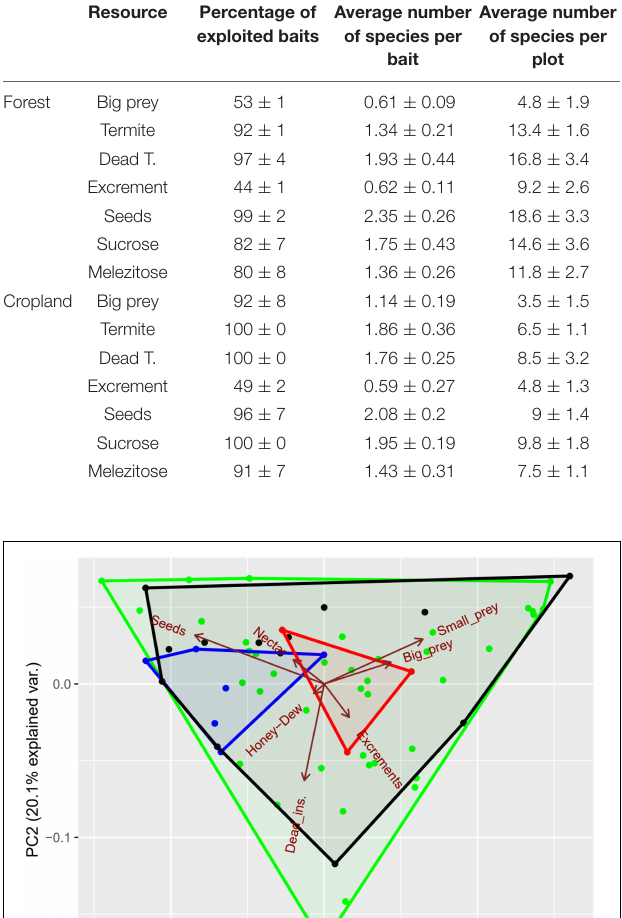
TABLE 1 | Resource exploitation intensity.